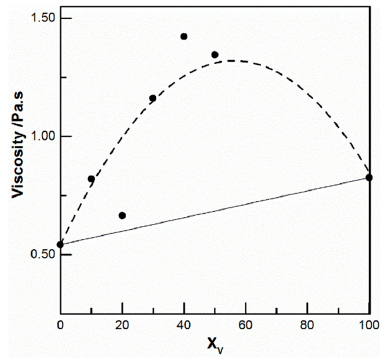
Figure 1. Variation of the viscosity of chitosan CS-102/ PEO (M = 1000 kg/mol) mixtures in 0.5 M acetic acid at 0.5 s − 1 as a function of weight fraction of PEO ( X v ). Total polymer concentration 5% w / v . PEO: poly(ethylene oxide); CS: Chitosan.